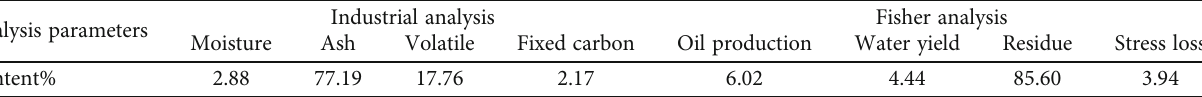
Table 1: Fushun oil shale industry analysis and aluminum retort analysis.